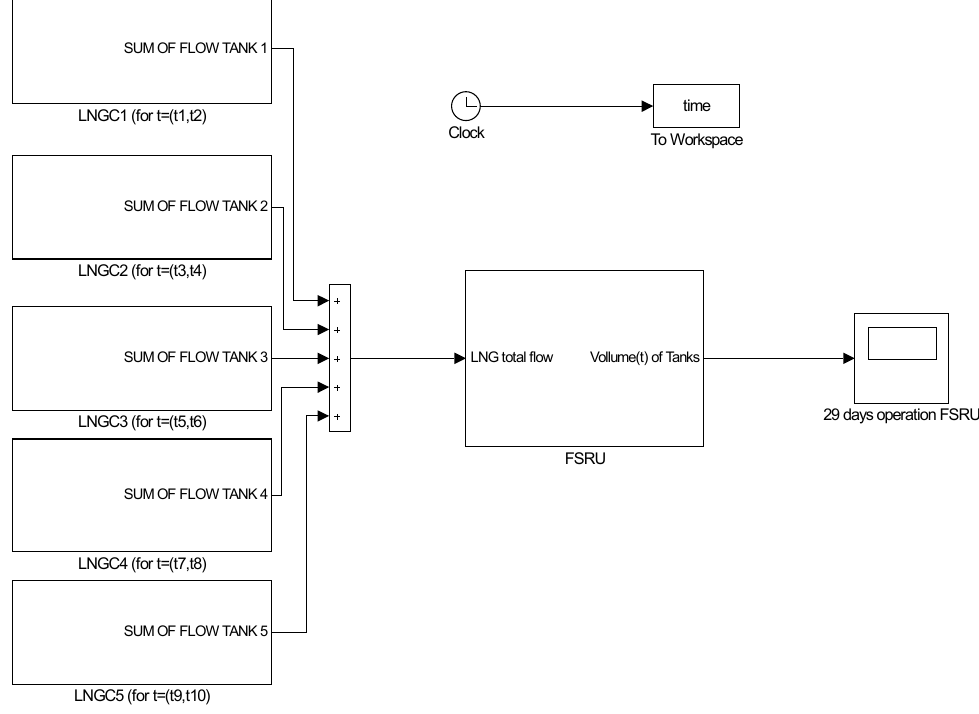
Figure 3. Conceptual representation of the simulation model.